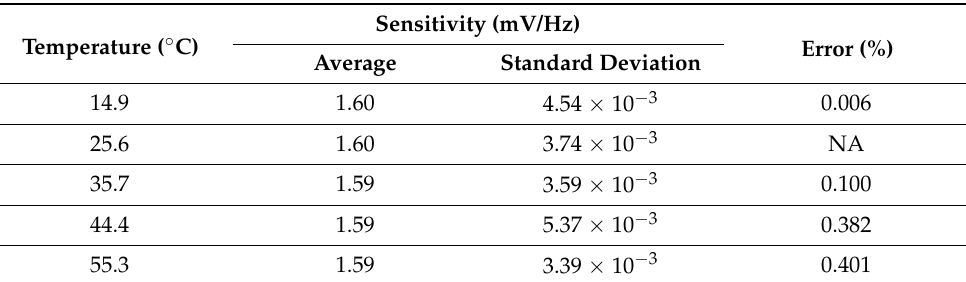
Table 1. System sensitivity at evaluated temperatures. Averages and standard deviations were cal- culated by five replicate experiments at different temperatures. Percent relative errors were calcu- lated based on the sensitivity at 25.6 °C.